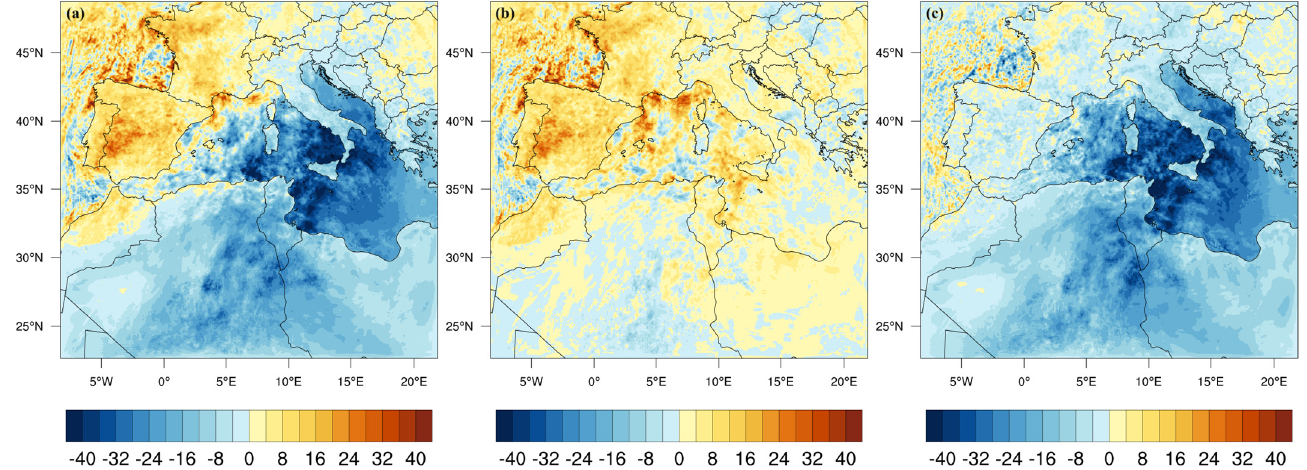
Figure 14. Simulated 8-day average surface energy budget anomaly Δ𝐸 for ( a ) FULL − CTL, ( b ) MP − CTL and ( c ) RAD − CTL. Units are W m − 2 . ( b ) MP − CTL and ( c ) RAD − CTL. Units are W m − 2 .